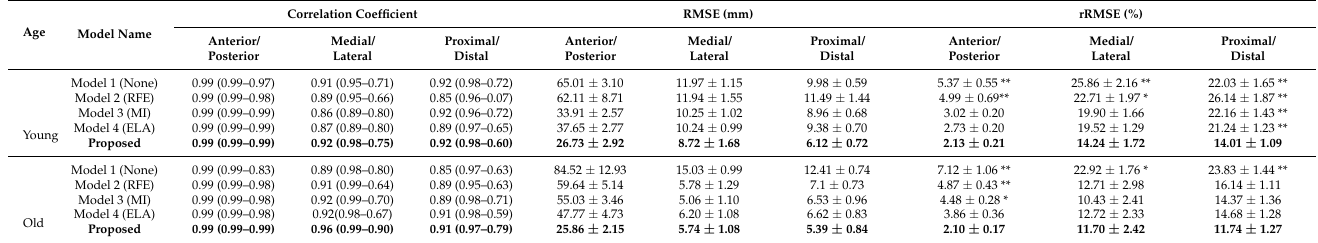
Table 2. Overall performance of CG prediction